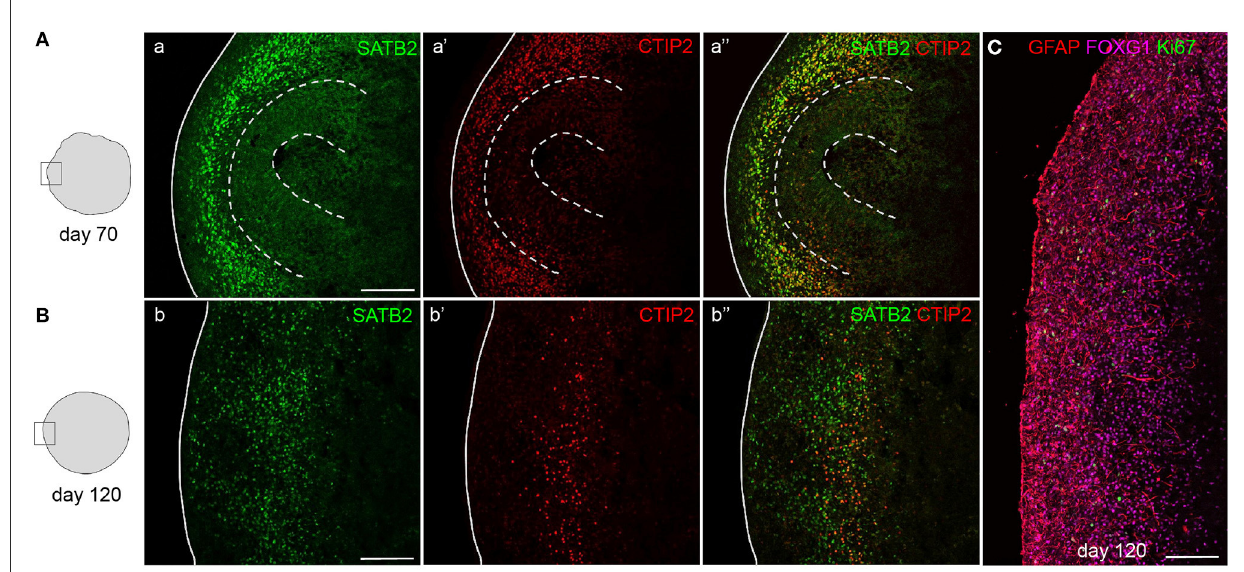
FIGURE6 Mature cortical organoids. Staining for upper-layer neurons (SATB2) and deep-layer neurons (CTIP2) in 70- and 120-day-old mature cortical organoids. After 70 days, progenitor zones are still present (indicated by dashed lines) and both types of neurons reside outside of these zones in a disorganized manner (A). In 120-day-old organoids, progenitor zones are absent and deep-layer neurons have compacted into a more organized layer, positioned below a layer of abundantly present upper-layer neurons (B) . Staining for astrocytes (GFAP), neurons (FOXG1), and proliferating cells (Ki-67) in a 120-day-old cortical organoid cortex-like region (C) . Scalebar: 150 µ m in all